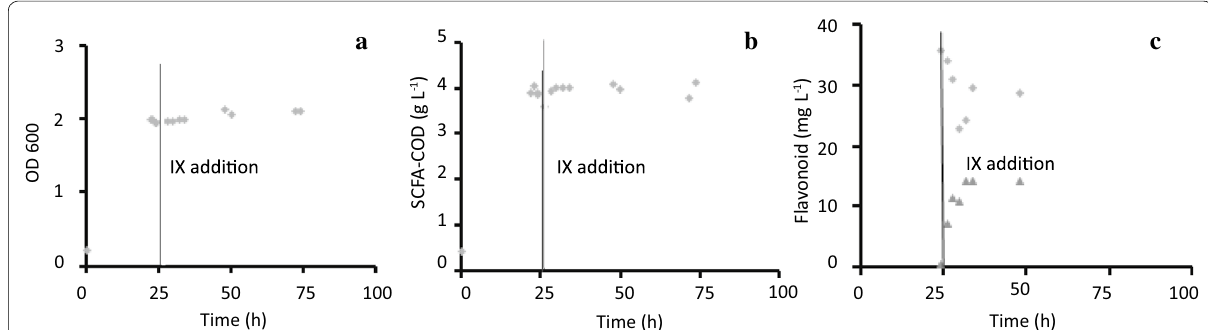
Fig. 3 Course of growth ( a ), basic metabolism, i.e., production of acetate and butyrate summed as chemical oxygen demand (COD) ( b ), and conversion of pure IX at 30 mg IX L − 1 (rhombi: IX; triangles 8-PN) ( c ) during stationary growth of Eubacterium limosum in reinforced clostridial medium at 37